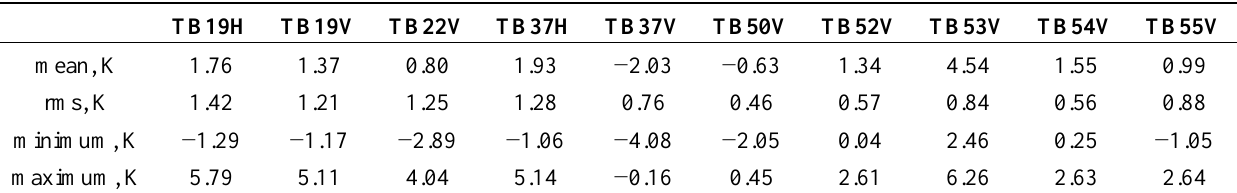
Table 4. Descriptive statistics of the differences between measured and calculated brightness temperatures for DMSP F16 SSMIS instrument for cloudless atmosphere.